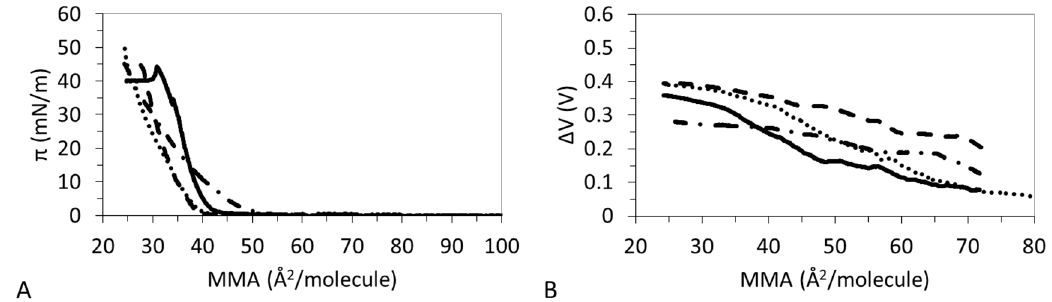
Figure 6. E ff ect of electrolyte on CHOL monolayers ( A ) π - A and ( B ) ∆ V – A isotherms. 15 mM NaCl (straight line), 5 mM CaCl 2 (dashed line), 5 mM MgCl 2 (dash-dotted line), 2.5 mM LaCl 3 (dotted line), respectively. Curves replotted from Figures 1 and 2.